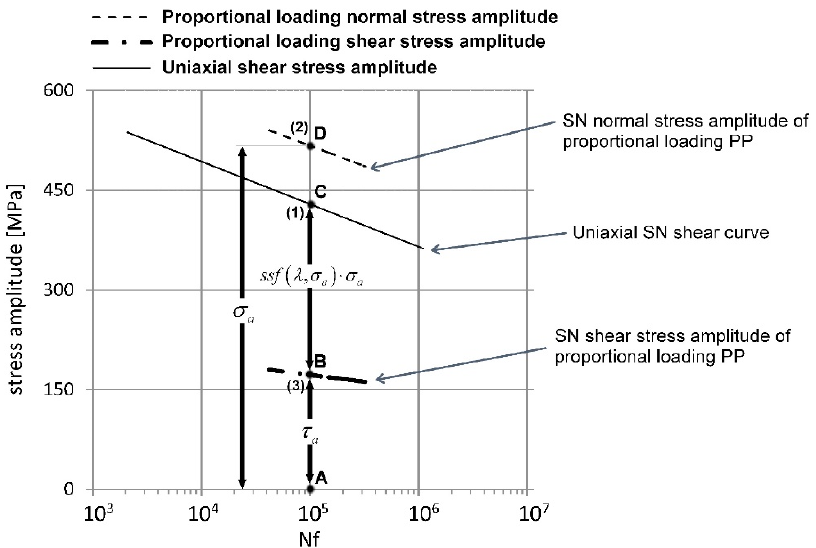
Figure 4. Different damage scales representation for normal and shear stress amplitudes considering a given fatigue strength (Nf).